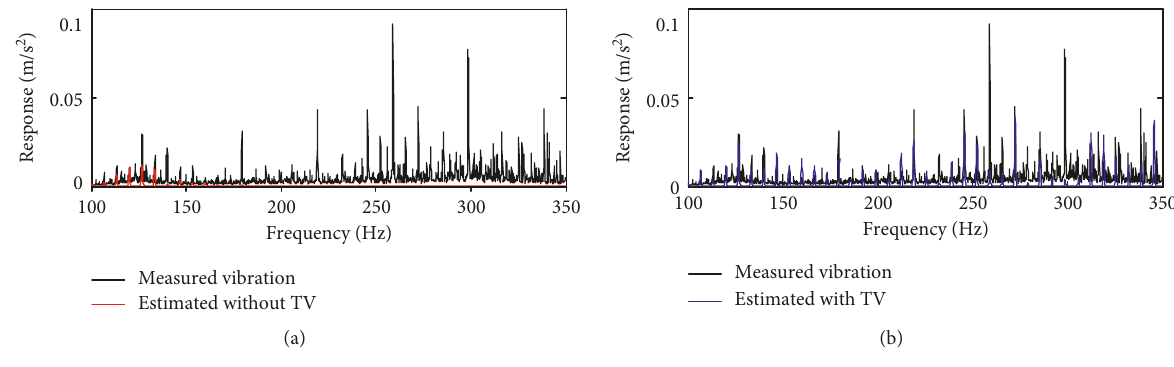
Figure 12: Comparison between estimated and measured vibration. Table 1: Overall acceleration level between estimated and measured